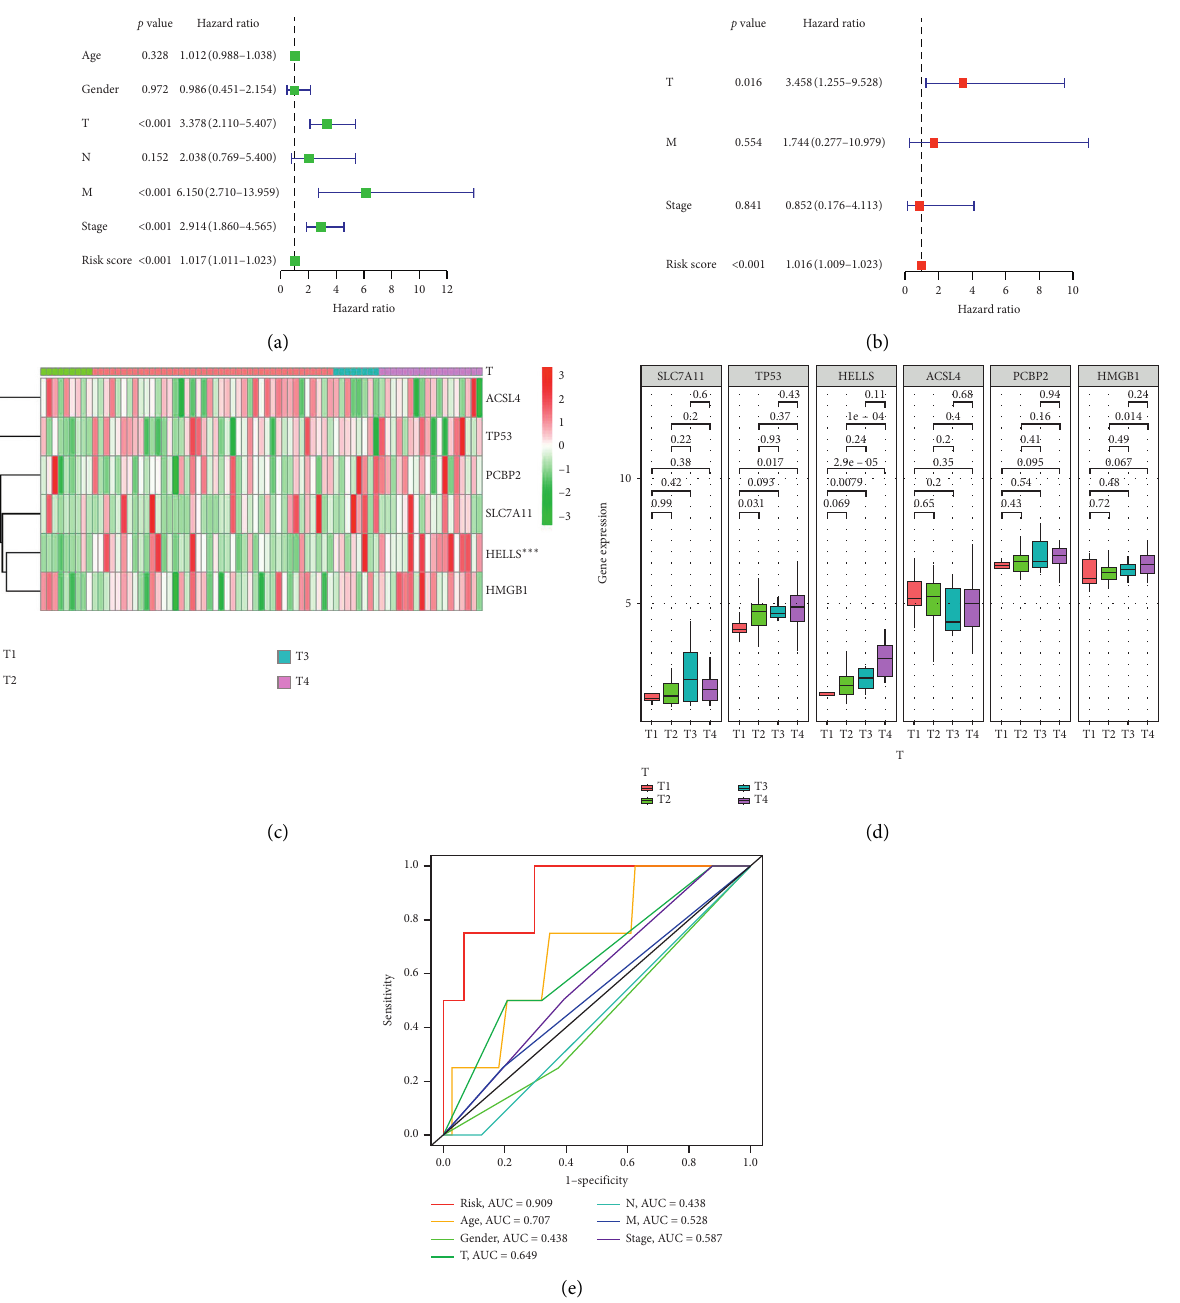
Figure 4: Independent prognostic value of the ferroptosis risk signature. (a), (b) Univariate and multivariate Cox regression analyses for evaluating the independent prognostic effect of the risk signature in TCGA cohort. (c) Heatmap of expressional profiles of 6 ferroptosis- associated genes at different Tstaging. (d) The expressional levels of 6 ferroptosis-associated genes at different Tstaging. (e) The AUC values of the risk